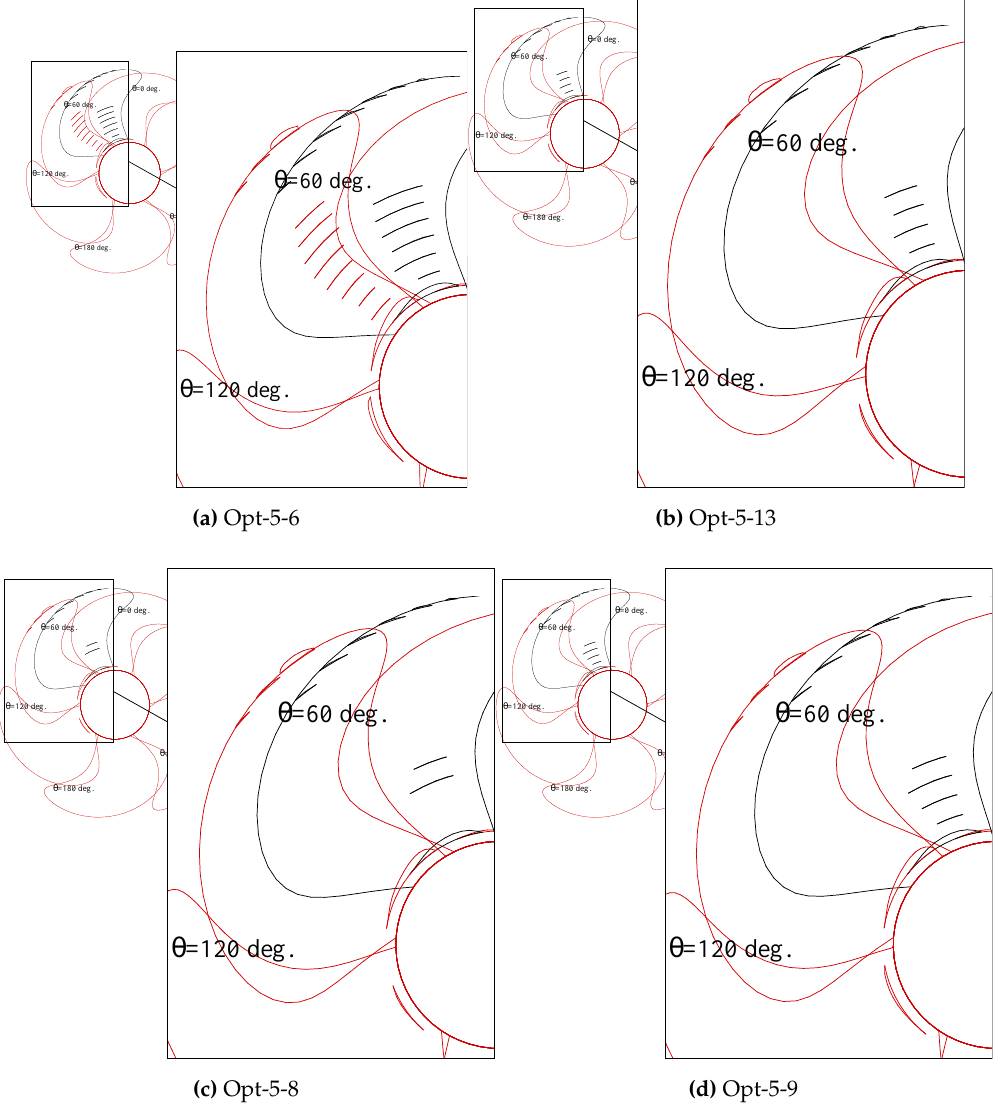
Figure 21. Cavitation performance of propeller case Opt-5. ( a ) Opt-5-6; ( b ) Opt-5-13; ( c ) Opt-5-8; ( d )